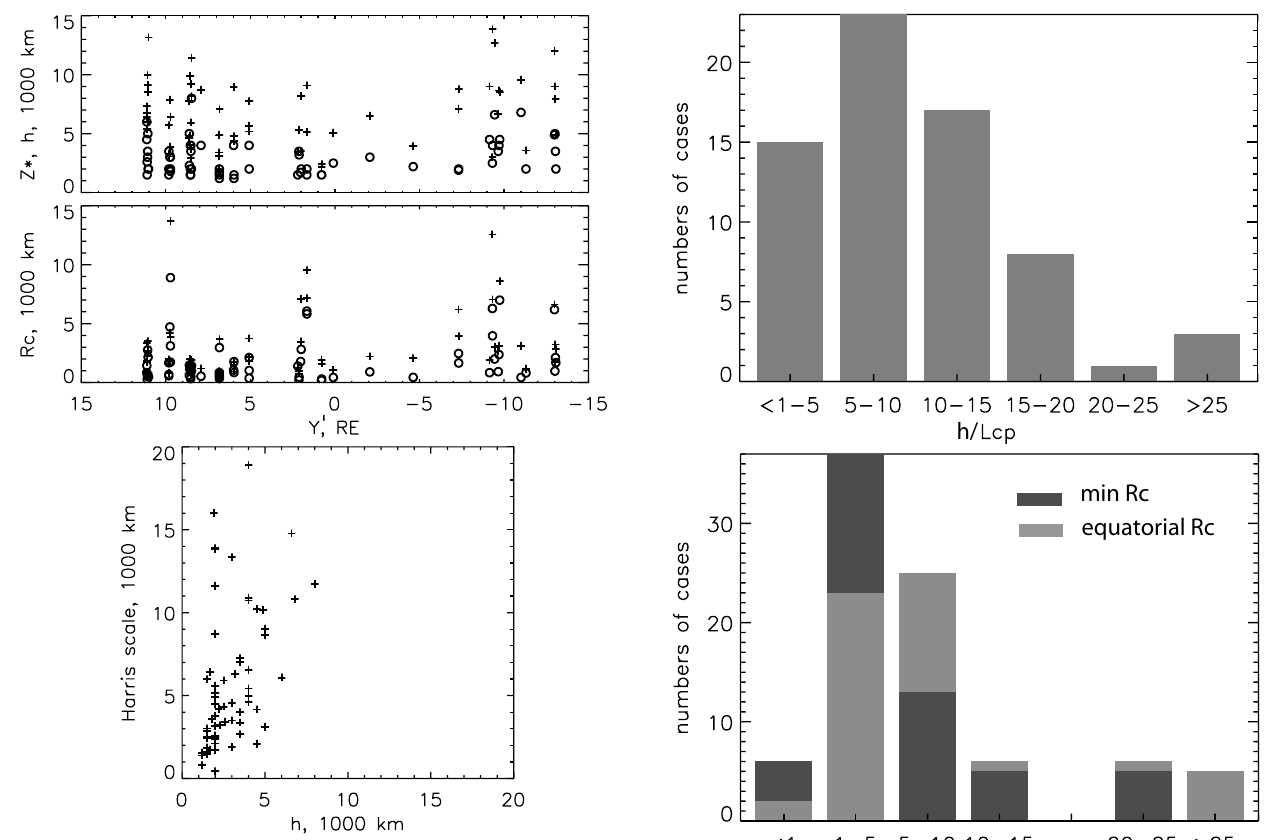
Fig. 9. Distributions of flapping amplitude (crosses), current sheet half-thicknesses (circles) and median radii of the magnetic field cur- vature in the NS ( R ceq , crosses) and minimum R c (circles) versus Y 0 (upper panel); Bottom panel: Comparison of gradient scales h , calculated according to Eq. (2) and Harris scales, Eq. (3).